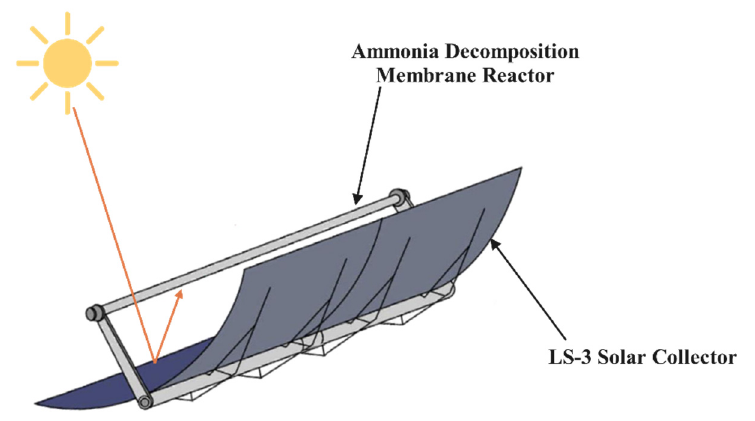
Figure 1. Model schematic of the ammonia decomposition membrane reactor.